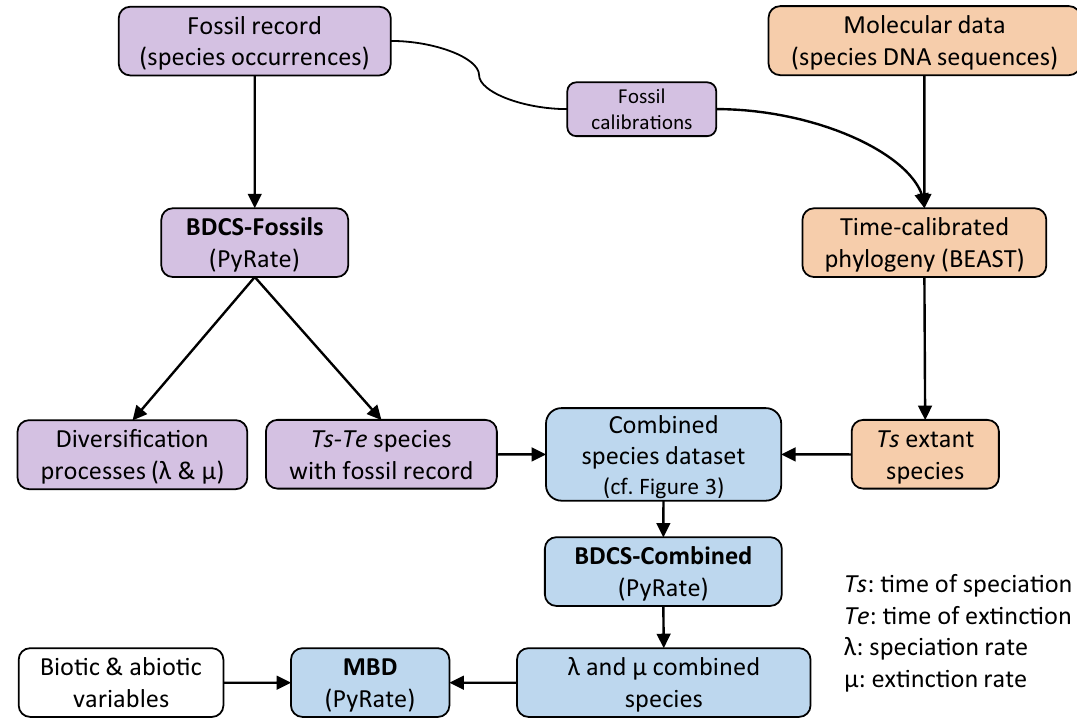
Figure 2. Schematic representation of the workflow of the study. We compiled the fossil record (purple colour) and molecular data (orange colour) at the species level for Carcharhiniformes that were analysed separately and jointly (blue colour). The fossil occurrence data are first analysed under a birth–death with constrained shifts (BDCS-Fossils) model, using PyRate, while jointly modelling the preservation process to estimate speciation (λ), extinction (μ), and preservation ( q ) rates. This also estimates the times of speciation ( Ts ) and times of extinction ( Te ) of all species with a fossil record. The DNA sequences were analysed with Bayesian